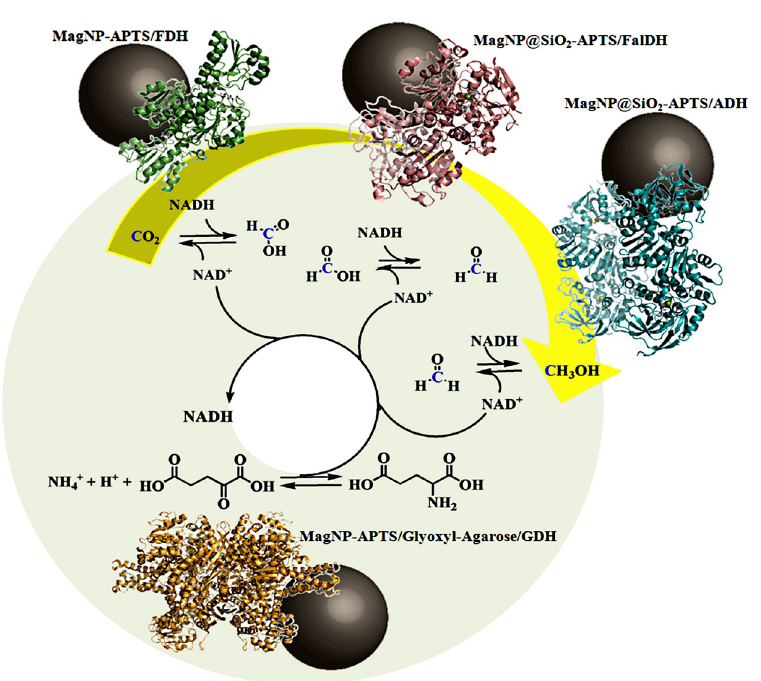
-methanol cycle using formate dehydrogenase (FDH) immobilized on Figure 2 - CO 2 MagNP-APTS, formaldehyde dehydrogenase (FalDH) and alcohol dehydrogenase (ADH) immobilized on MagNP@SiO -APTS and glutamate dehydrogenase (GDH) 2 immobilized on MagNP-APTS/Glyoxyl-Agarose. The MagNP-APTS/Glyoxyl- Agarose/GDH system was used as a NADH